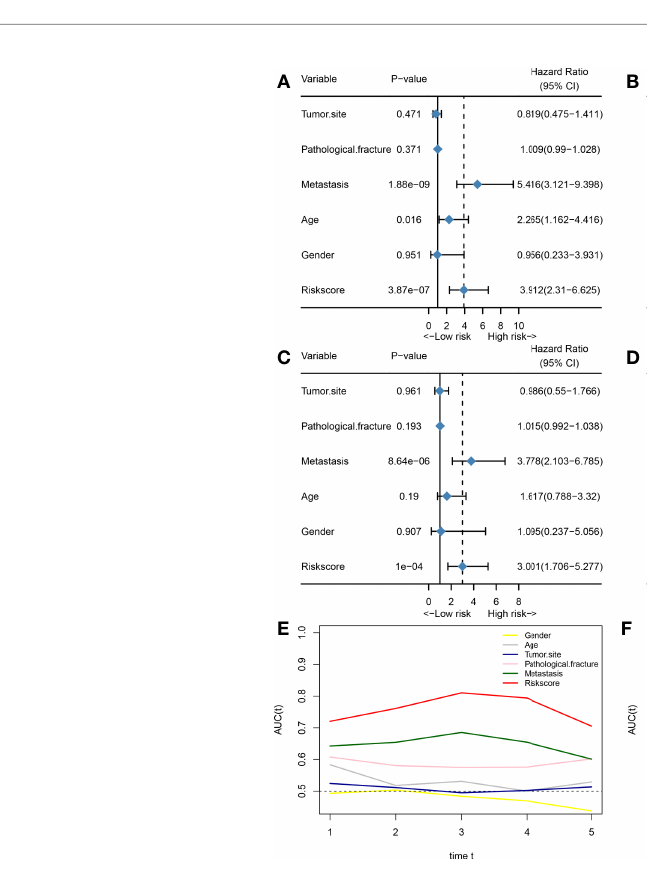
FIGURE 3 | HPSS is an independent prognostic factor for overall survival in patients with osteosarcoma and has certain advantages compared with clinical characteristics. (A) Forest plot showing the results of univariate COX regression analysis of HPSS and clinical characteristics in the training set; (B) Forest plot showing the results of multivariate COX regression analysis of HPSS and clinical characteristics in the training set; (C) Forest plot showing the results of univariate COX regression analysis of HPSS and clinical characteristics in the validation set; (D) Forest plot showing the results of multivariate COX regression analysis of HPSS and clinical characteristics in the validation set; (E) Time-dependent ROC curves showing the predictive power of HPSS and clinical features in the training set; (F) Time-dependent ROC curves showing the predictive power of HPSS and clinical features in the training set; It can be seen that the predictive power of each variable varies over